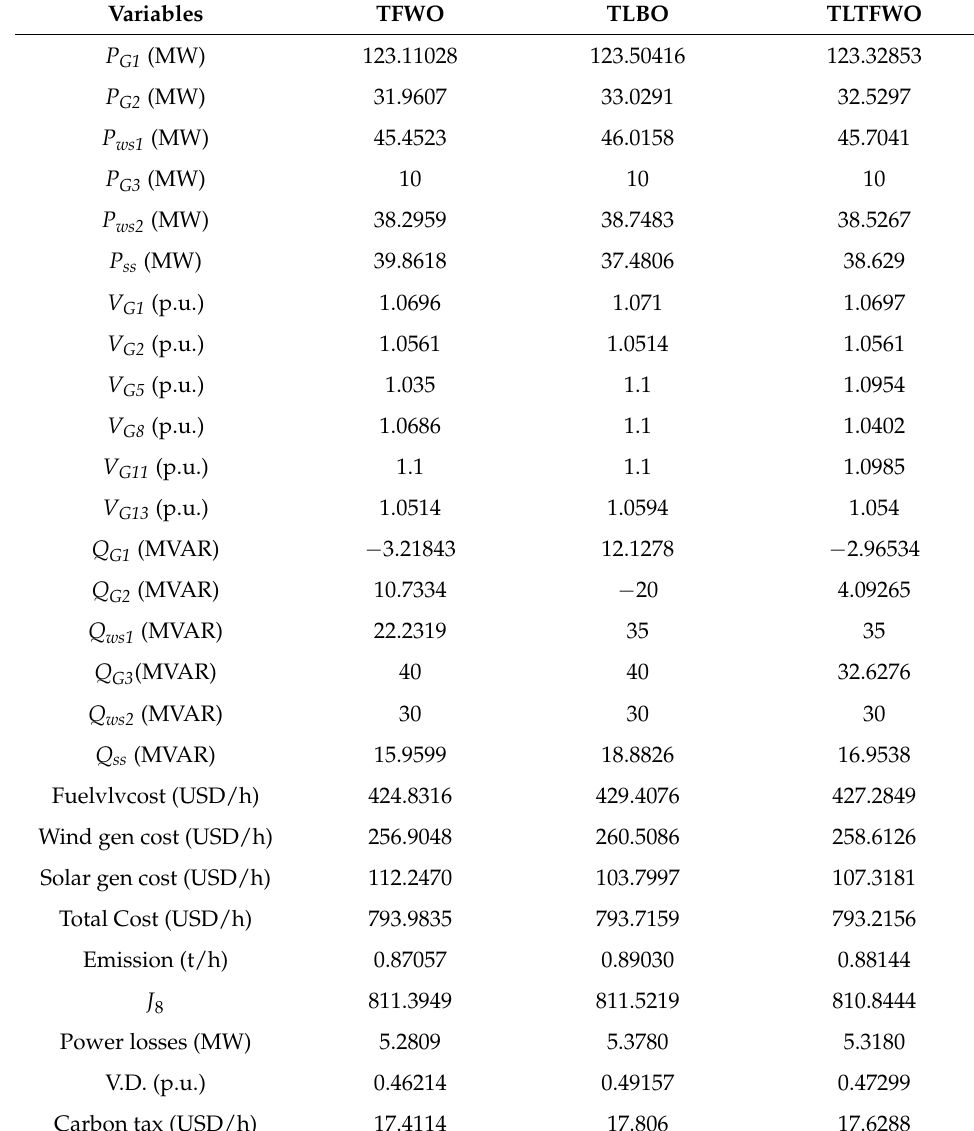
Table 12. The variables’ optimal values obtained for Case